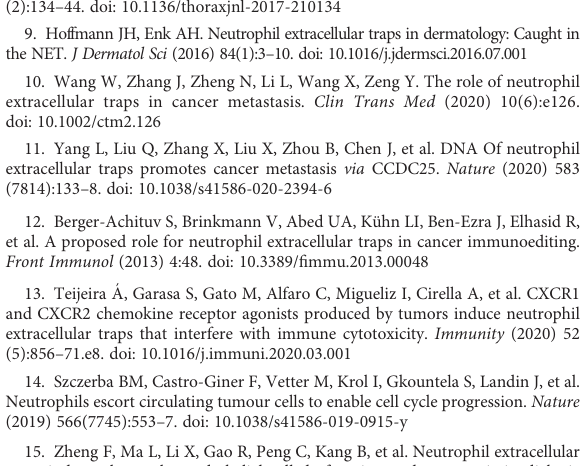
SUPPLEMENTARY FIGURE 2 The expression pro fi les, mutation, and survival analysis of cores genes.